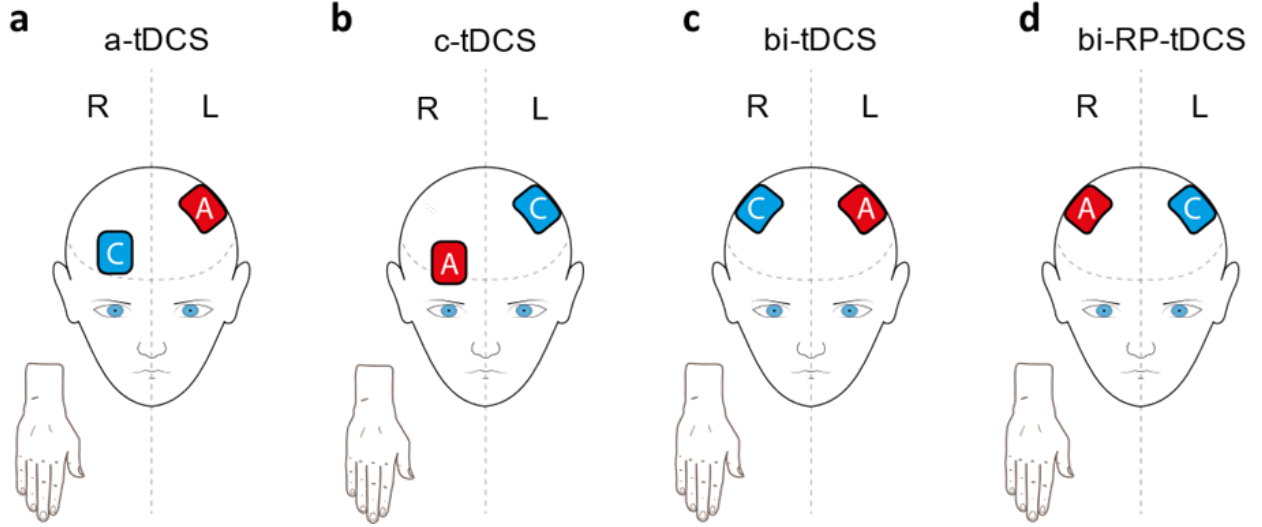
Figure 1. tDCS applications: ( a ) anodal tDCS (a-tDCS) where anode (A) is over contralateral motor cortex (M1) and cathode (C) over homolateral prefrontal cortex; ( b ) cathodal tDCS (C-tDCS) where anode is over homolateral prefrontal cortex and cathode over contralateral M1; ( c ) bi-hemispheric tDCS (bi-tDCS) where anode is over contralateral M1 and cathode over homolateral M1; and ( d ) reversed-polarity bi-hemispheric tDCS (bi-RP-tDCS) where anode is over homolateral M1 and cathode over contralateral M1.